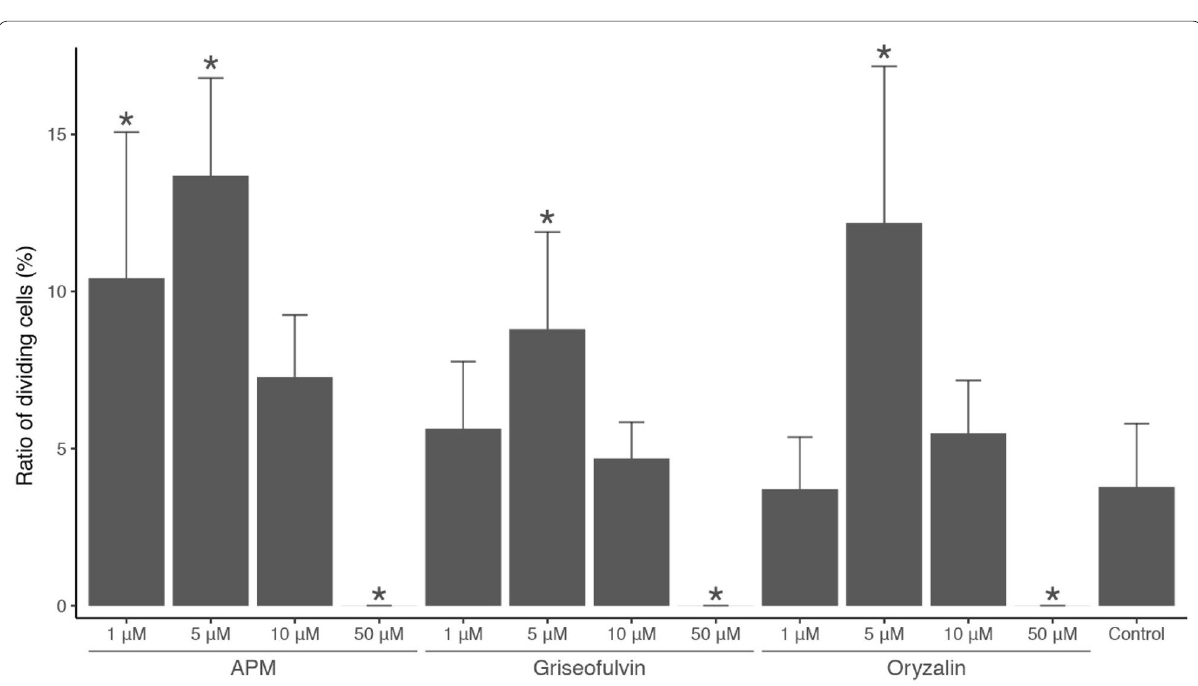
Fig. 3 Ratio of dividing cells in gametophytes (mean and 95% confidence interval) after treatment with mitotic inhibitors. The asterisks indicate that the ratios are significantly different from that of the control (no treatments)